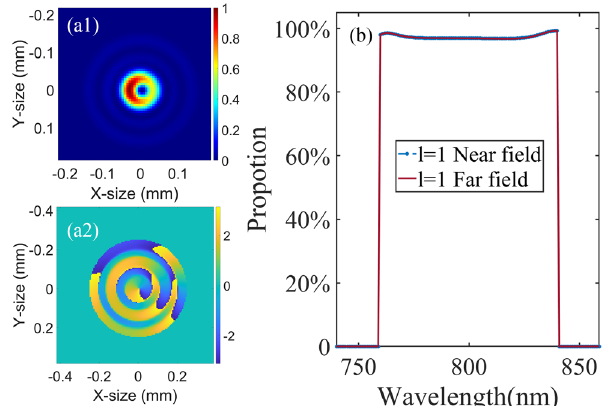
Figure 10. Focused intensity distribution ( a1 ) and phase distribution ( a2 ) of amplified beam corresponding to L = 15 mm. ( b ) Proportion of l = 1 of the far field and near field with the